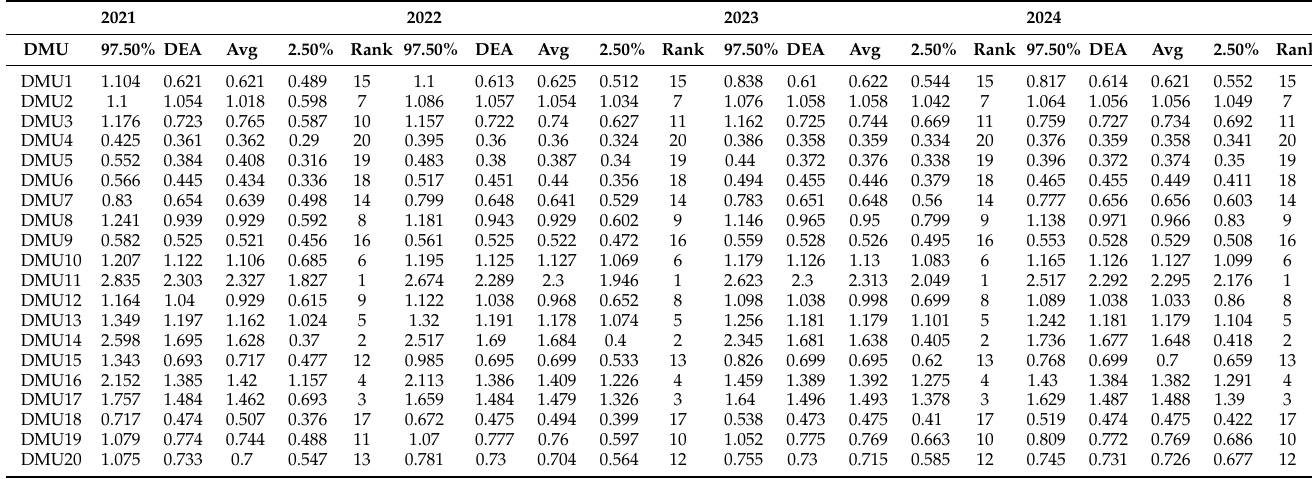
Table A1. 2021–2024 forecast DEA and confidence